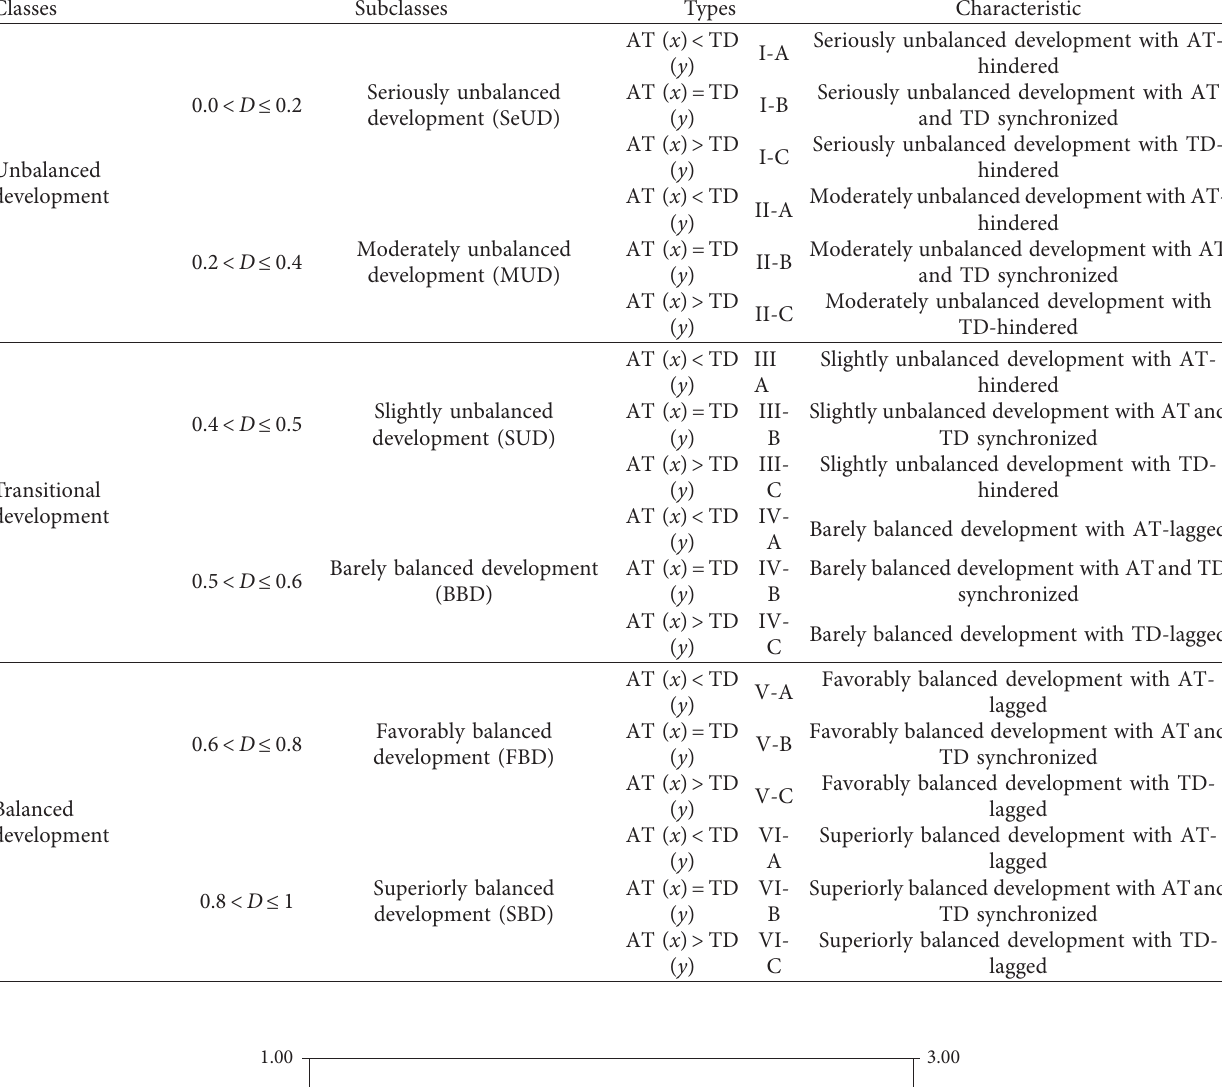
Table 4: Coordinated development types of AT and TD.